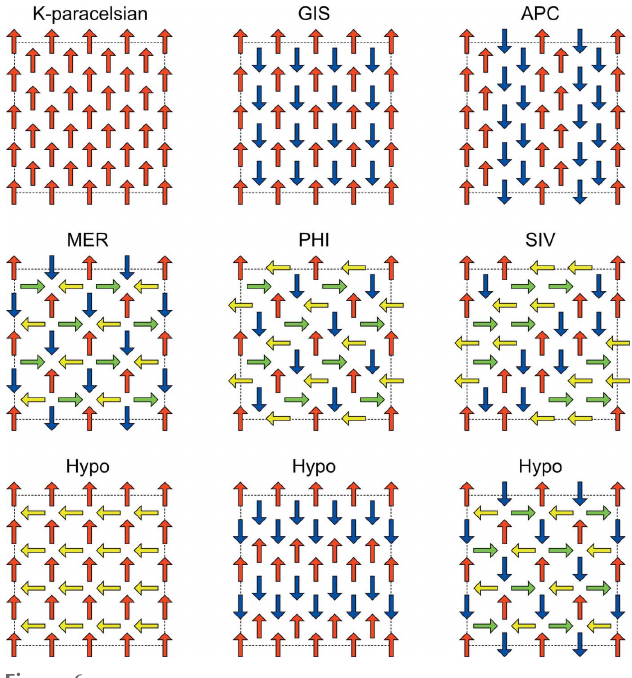
Figure 6 Schematic drawing of the building scheme used to construct the zeolite topologies in the family of dense double-crankshaft topologies. Each arrow represents a double-crankshaft chain, as seen in projection along the chain direction, and the direction of the arrow indicates the relative rotational orientation. There is only one physically meaningful solution to the connectivity between double-crankshaft chains for each of the schematic drawings, which results in the final topology. Colours have been applied for visual emphasis of symmetry.